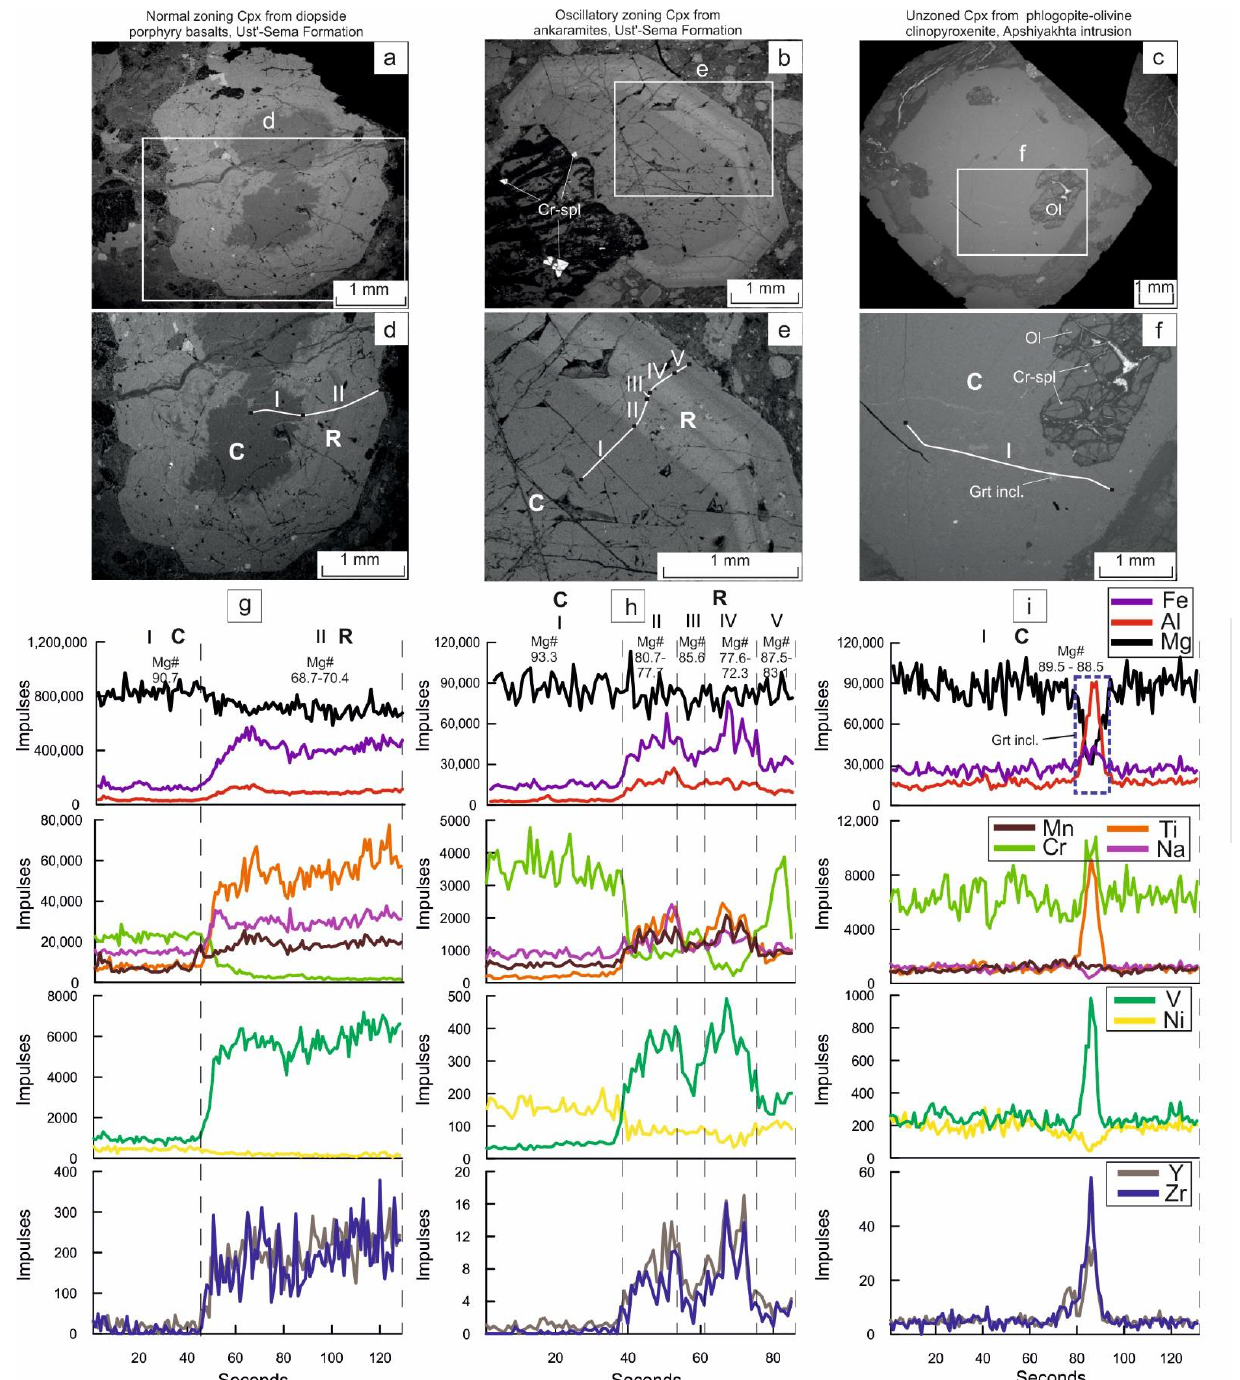
Figure 6. Zoning clinopyroxene crystals from the Ust’-Sema Formation and the Barangol Complex rocks, Gorny Altai: ( a – c ) back-scattered electron (BSE) images of clinopyroxene crystals (general view); ( d – f ) back-scattered electron (BSE) images of enlarged rims, and the lines indicate the laser beam path; ( g – i ) variations of major- and trace-elements using LA-ICP-MS (pulses per second). Mg# in the diagrams used are from the SEM EDS. The pronounced peak in diagram (i) is a result of the existence of a secondary Ca – garnet inclusion (Grt incl). C — core; R — rim.